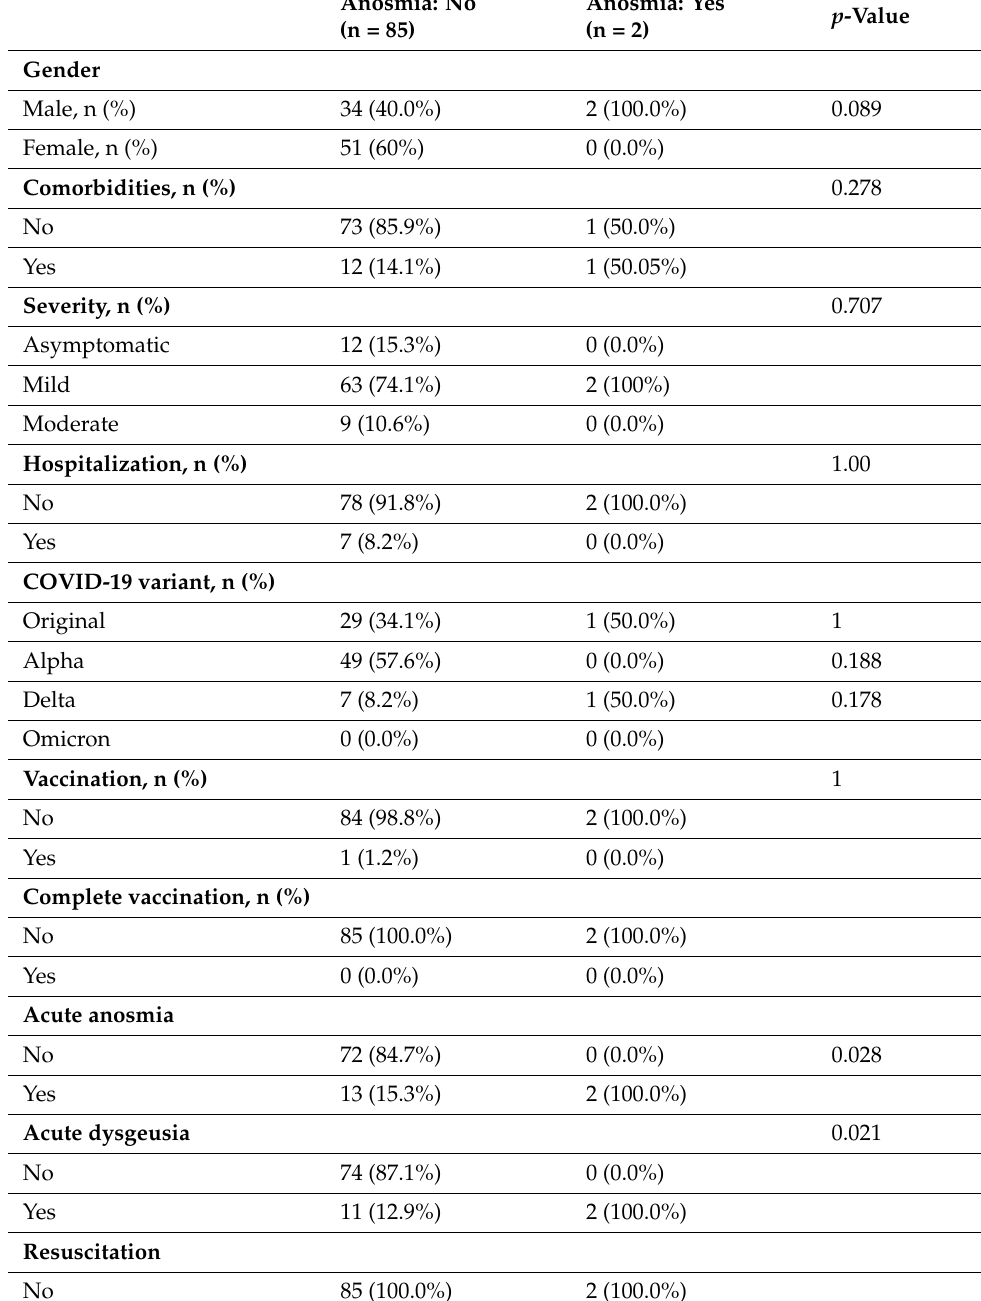
Table 9. Anosmia at FUP